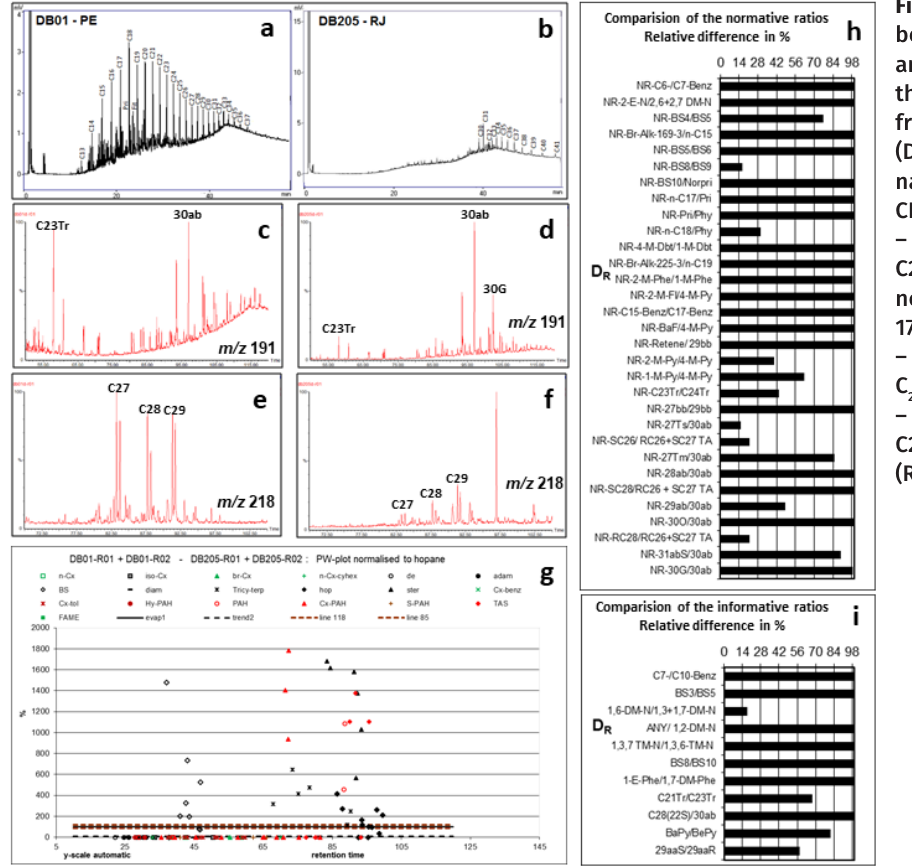
Figure 9. Combined results between samples